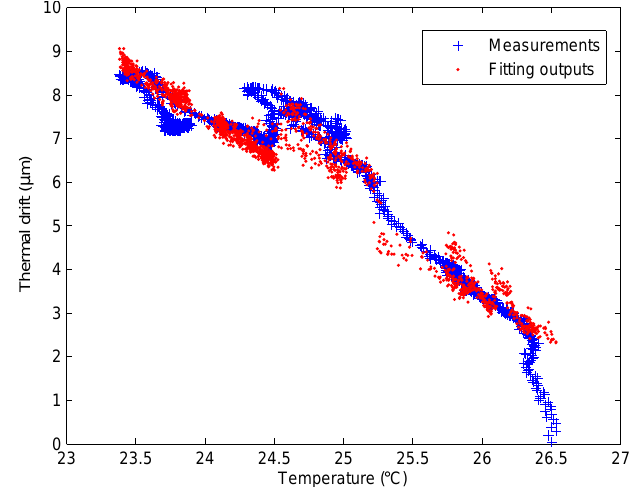
Figure 3. Relationship between the thermal drift and temperature during the 2-days measurement in ambient